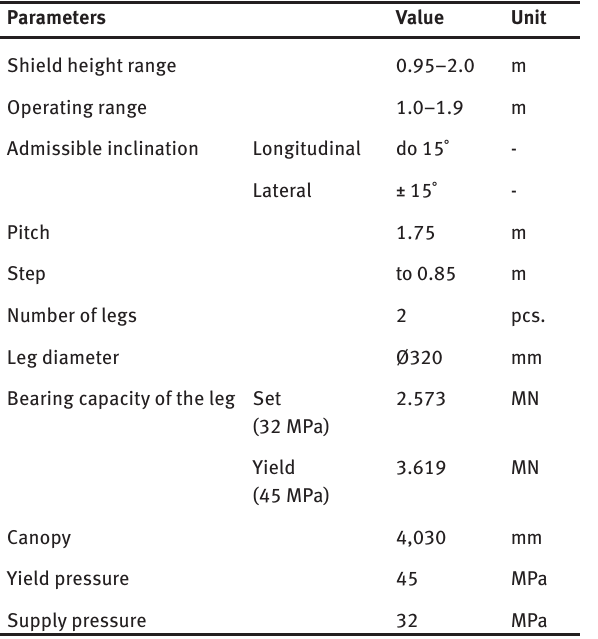
Table 1: Operating parameters of powered roof support (shield) sections.